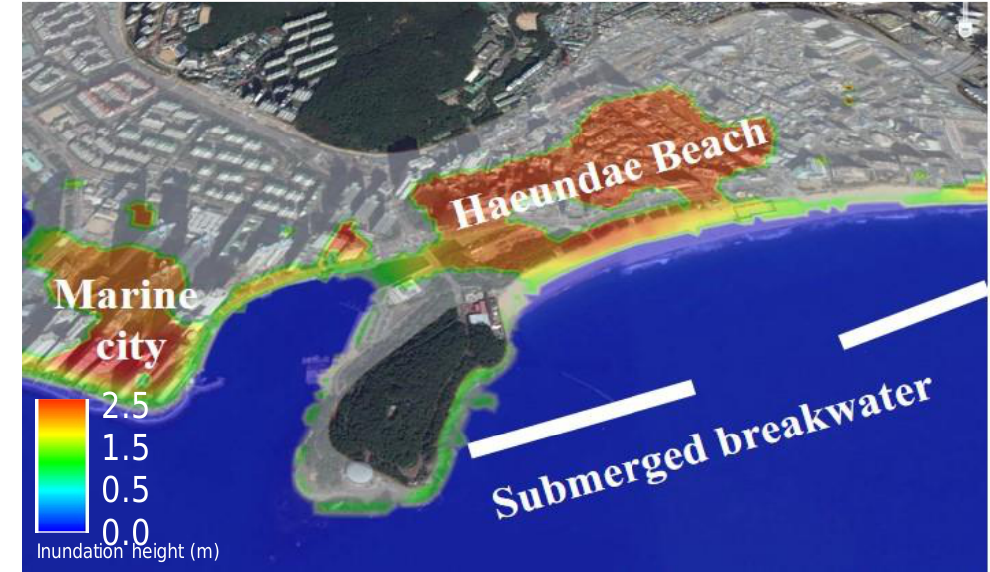
Figure 13. Simulated 2-D contour map with peak coastal inundation . Figure 12. Simulated 2-D contour map with peak coastal